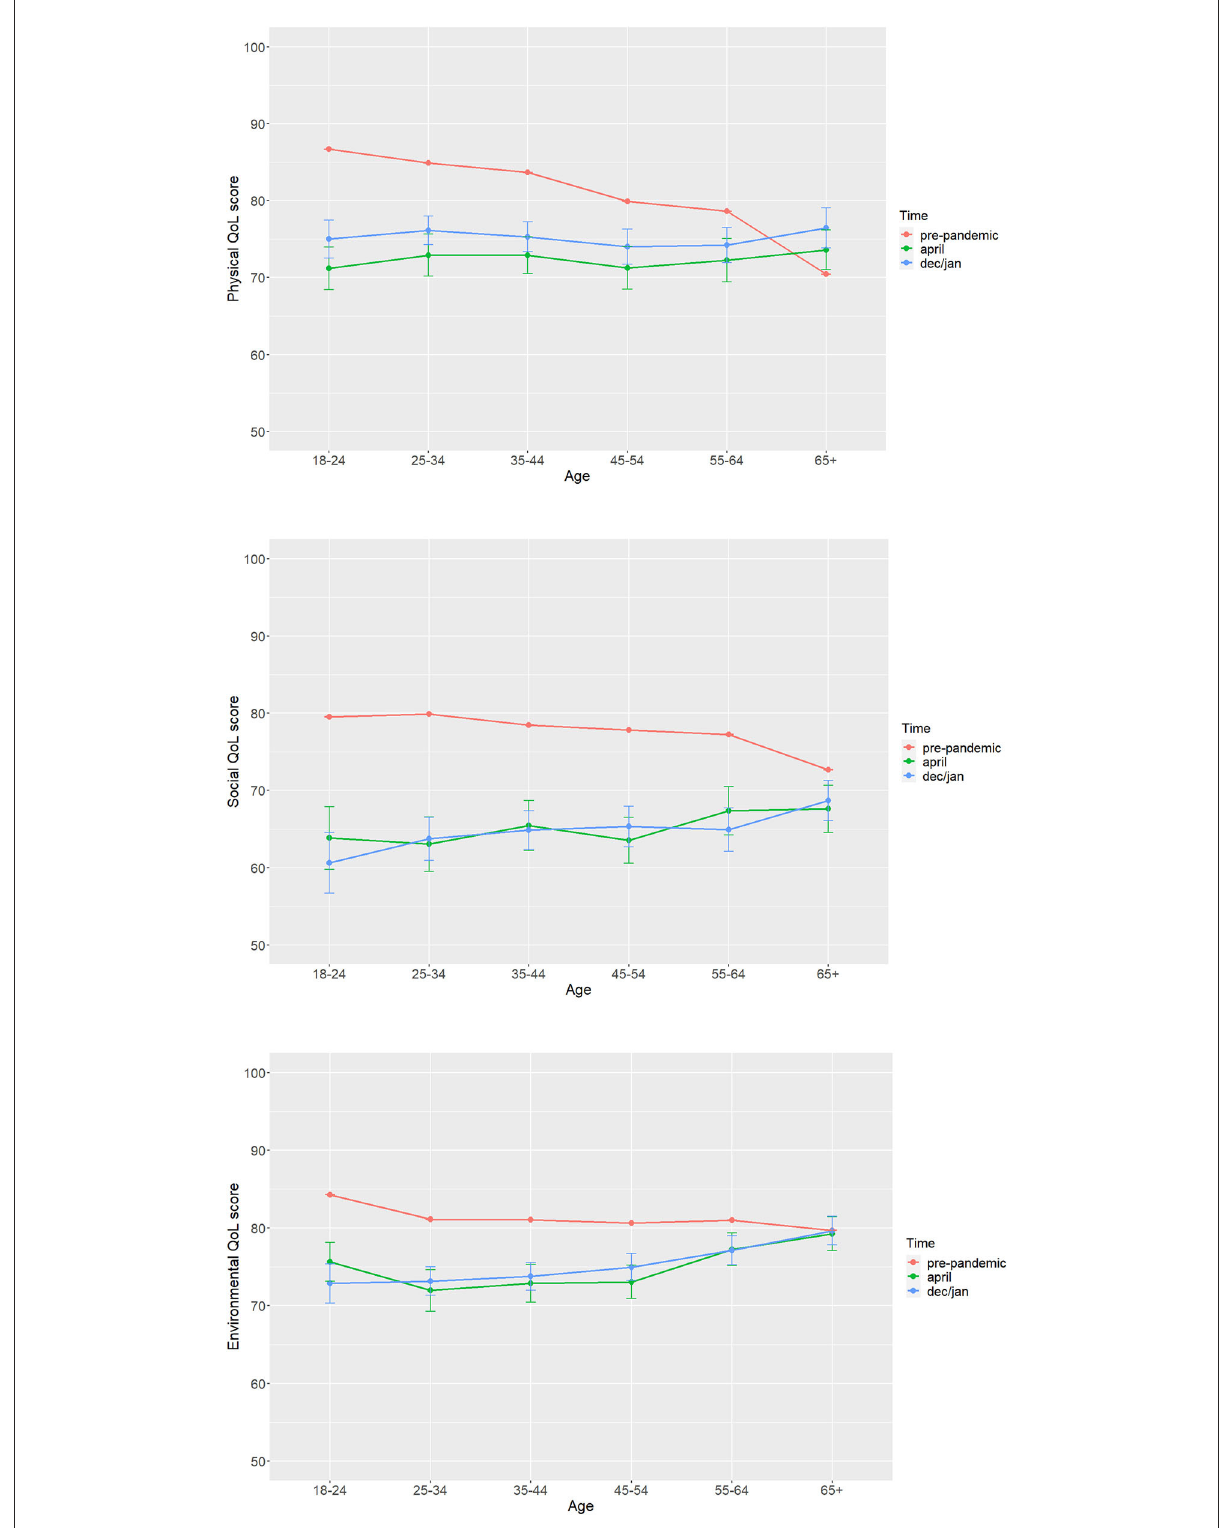
FIGURE1 Mean quality of life scores for each age group at all three time